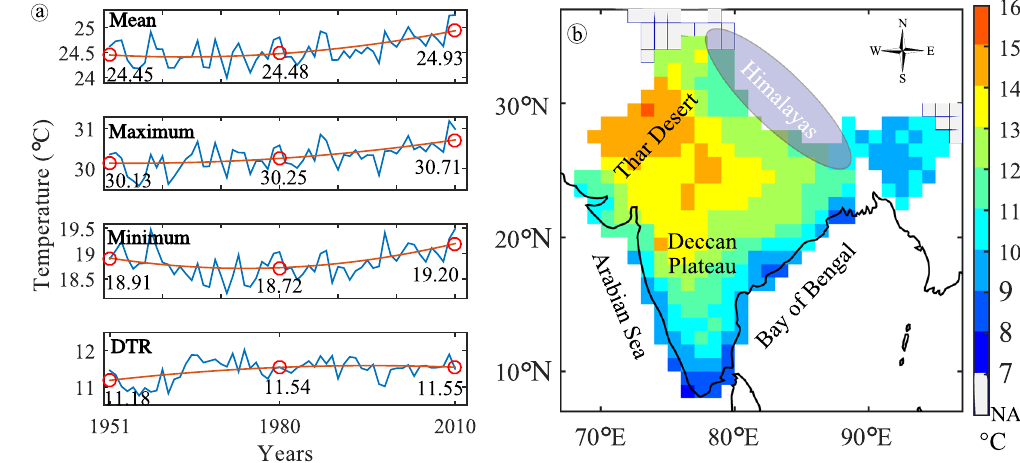
Figure 1. ( a ) Annual variation of spatially averaged annual temperature over India and (b) Average DTR from 1951 to 2010. Grids with inconsistent data are shown in grey colour (extreme bottom of colour bar), which is represented as NA (Not Analysed). The maps were generated using the software MATLAB (version 2014b).